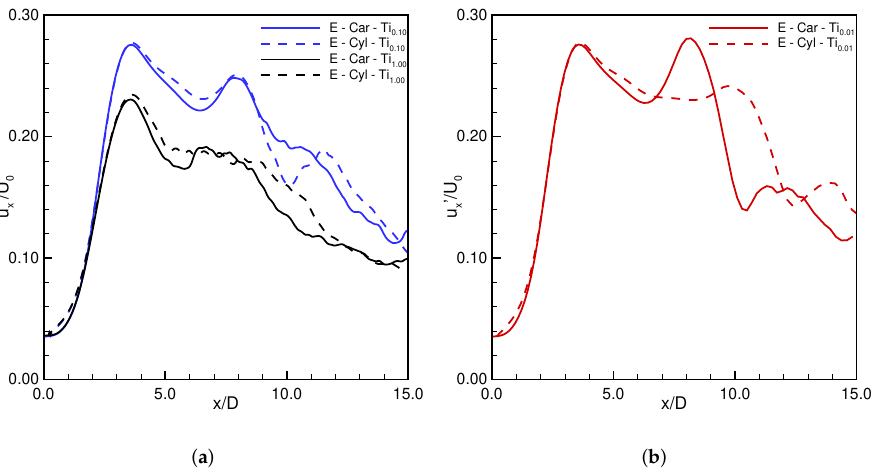
Figure 7. Profile of the axial velocity fluctuations along the jet axis in excited jets in the Cartesian and cylindrical coordinate systems at Ti = 1.0%, Ti = 0.1% ( a ) and Ti = 0.01% ( b